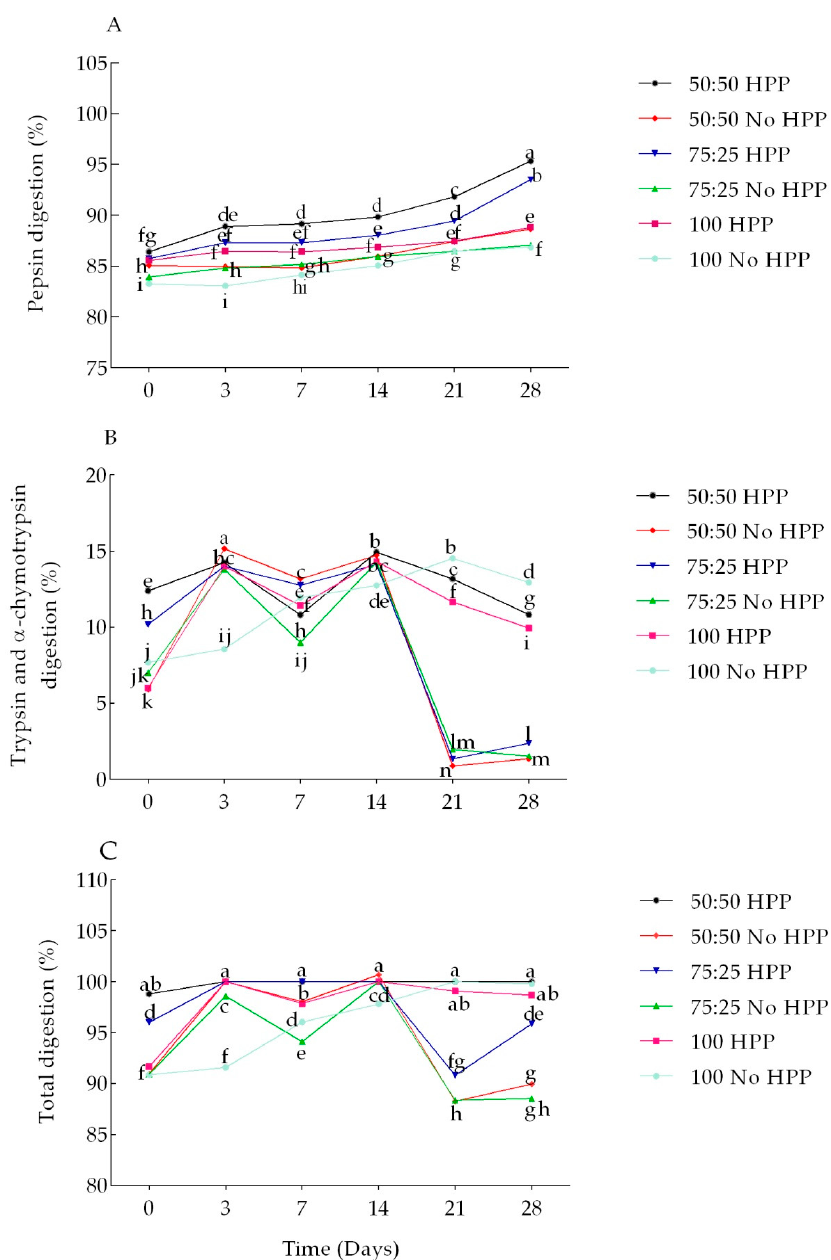
Figure 5. Effect of partial substitution of NaCl coupled with HPP on ( A ) pepsin digestion, ( B ) trypsin and α -chymotrypsin, and ( C ) total digestion of beef sausage under different cold storage days. Different lower case letters indicate significant differences at p < 0.05 in Duncan’s multiple range tests using two-way